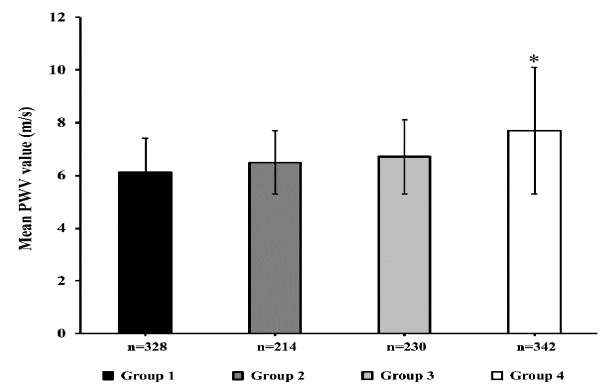
Figure 1. Mean pulse wave velocity (PWV) values in four groups according to the median of HOMA and uric acid (UA). Group 1 = individuals with UA < median values and HOMA < median ( n = 328, black column); Group 2 = UA > median, HOMA < median ( n = 214, dark grey column); Group 3 = UA < median, HOMA > median ( n = 230, light grey column); Group 4 = UA > median, HOMA > median ( n = 342, white column). * p < 0.0001 for the fourth group as compared to the three other groups.